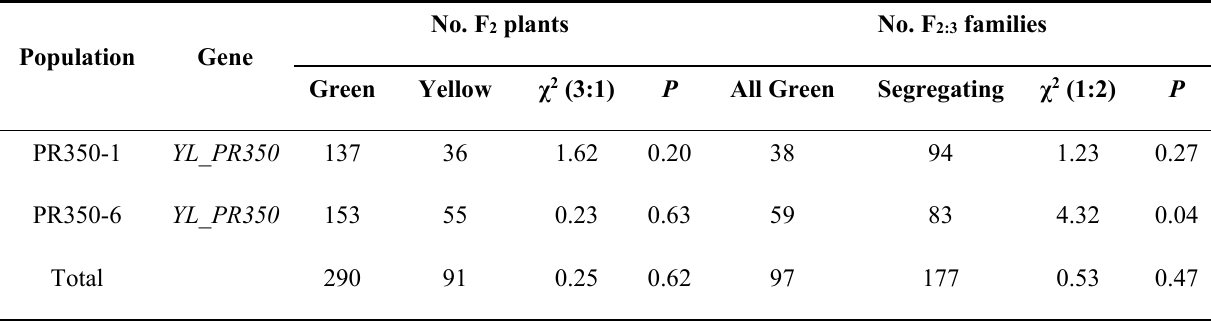
Table 1. Segregation patterns, Chi-square values and P-values for the PR350-1 and PR350-6